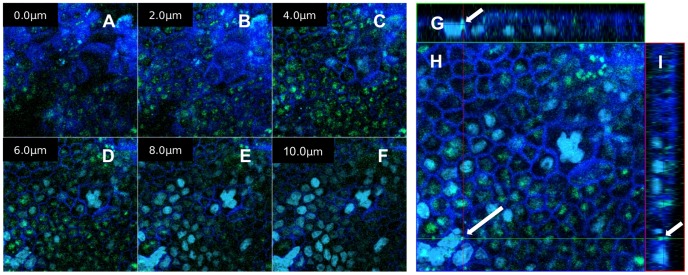
Cyclodextrin enters differentiated Caco-2 cells of a high resistance Caco-2 cell layer.A confluent layer was treated with 0.05-RAMEB and imaged by confocal microscope in twelve two-micrometer thick sections, of which six are demonstrated in the panels on the left side (A–F). On the right, one middle section of the image shows the top view of the cell layer (H) at the level indicated by blue lines in side sections. Upper (G) and right (I) side images are appropriate sections from perpendicular directions at green and at red lines. Crosshair (green and red lines at the long white arrow) set to an intense FITC-RAMEB (green) granule (indicated by arrows), which is located at the nuclear (light blue DAPI stain) level of cells. Several smaller FITC-RAMEB green granules can be seen below the cell membrane marked by CellMask (dark blue).